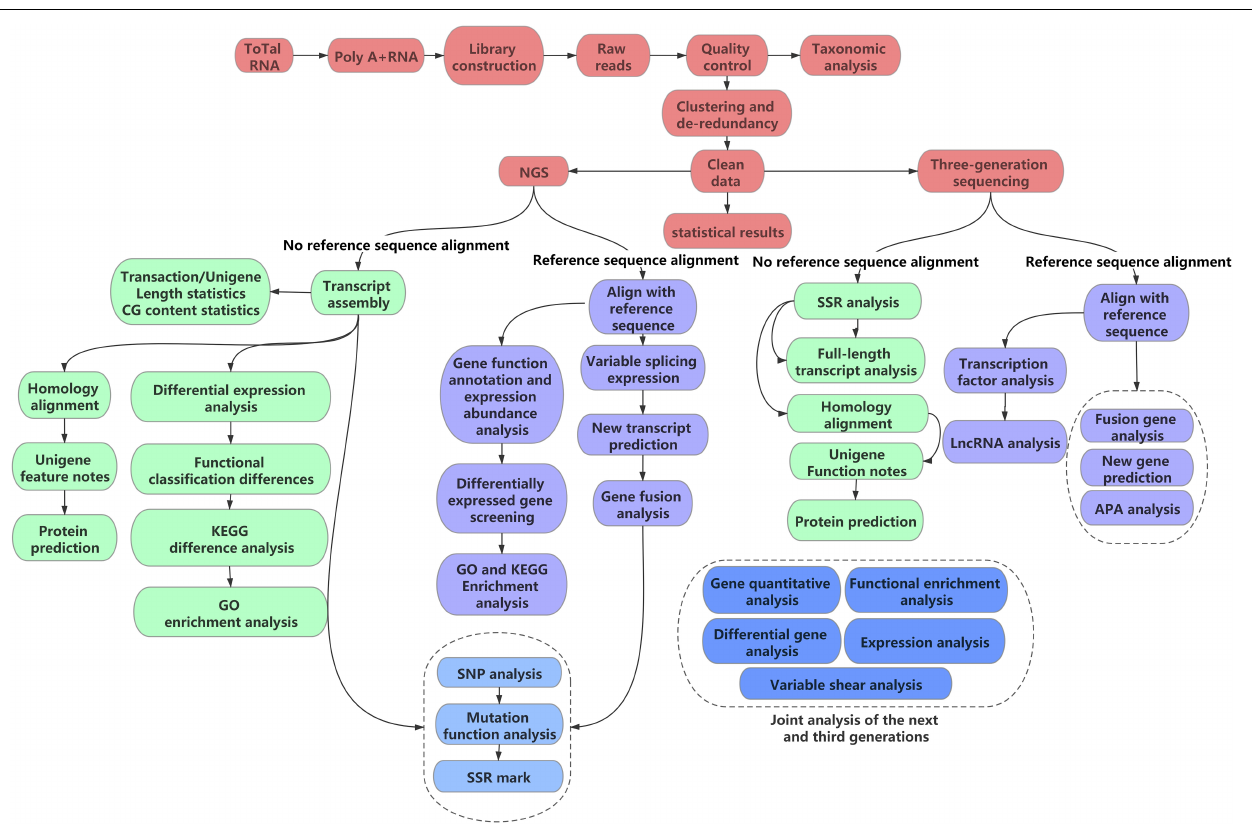
FIGURE 1 | Flow chart of transcriptome